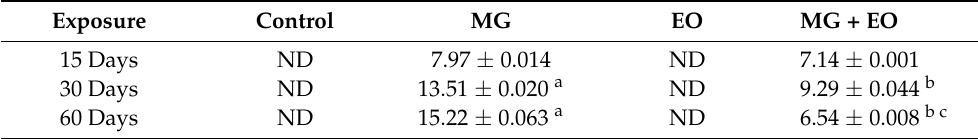
Table 1. Bioaccumulation of MG in liver of C. carpio exposed for 15, 30 and 60 days. Exposure